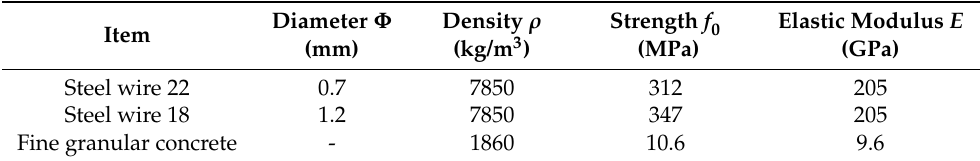
Table 3. Properties and key dimensions of materials used to construct the model structure. Item